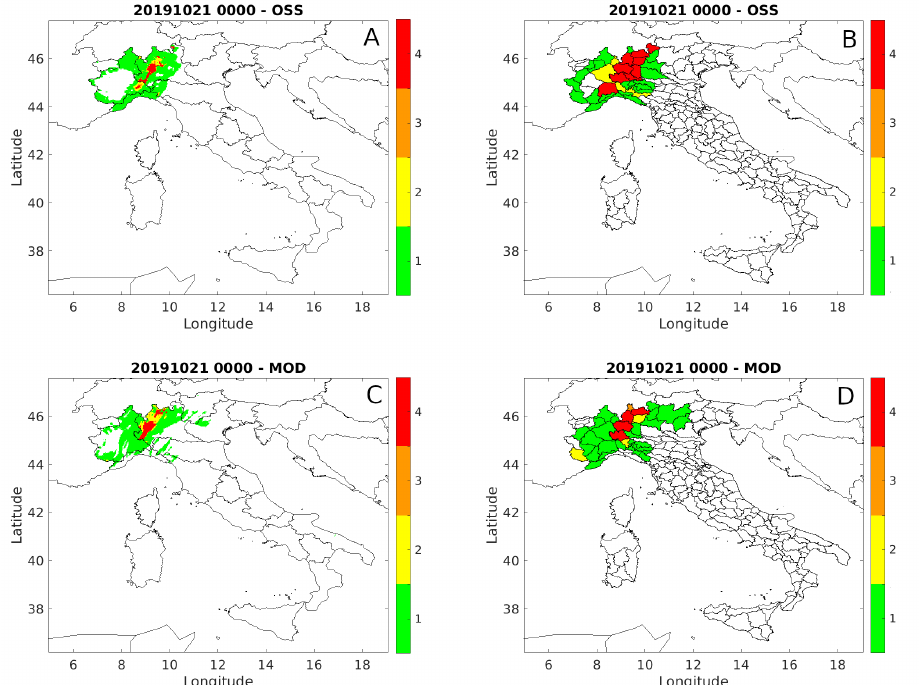
Figure 11. Scenario generated for the 21 October 2019 event at 00 UTC for the next 6 h. Panels ( A , B ) refer to observed scenario, panels ( C , D ) to the modeled